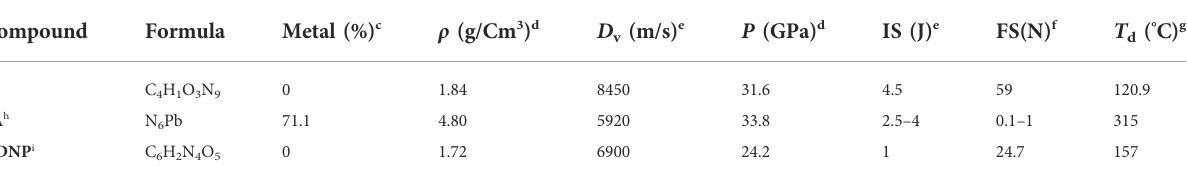
TABLE 2 Properties of compound 5.